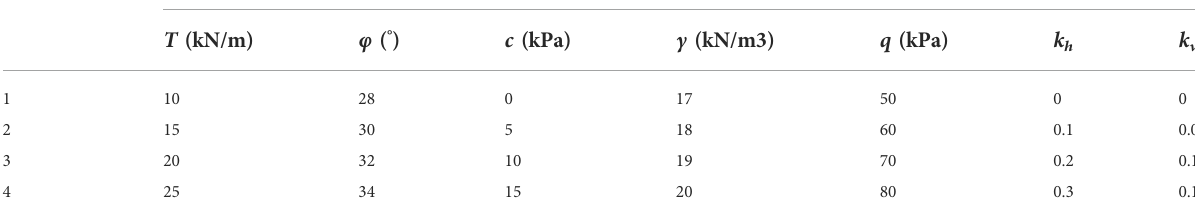
TABLE 3 Factors and levels of the orthogonal test.